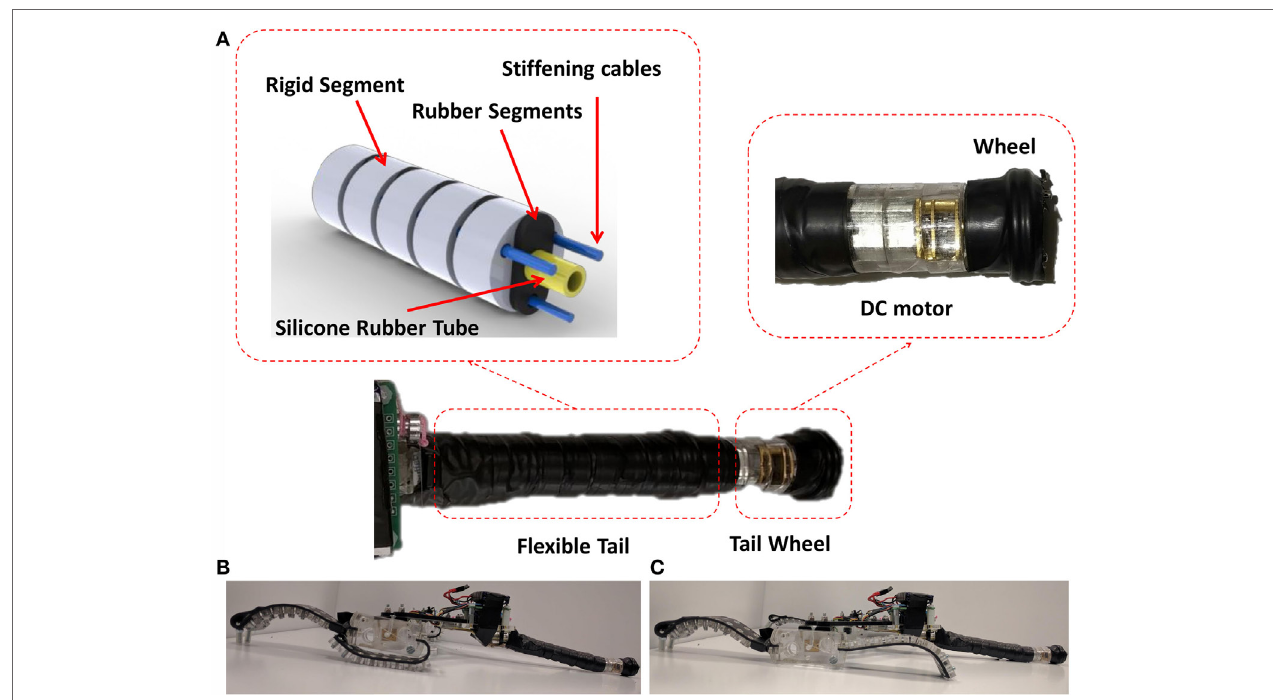
FigUre 4 | (a) Flexible tail constructed by rigid segments and flexible segments with an active wheel at the end. (B) Configuration of the wheels in backward crawling. (c) Configuration of the wheels in forward